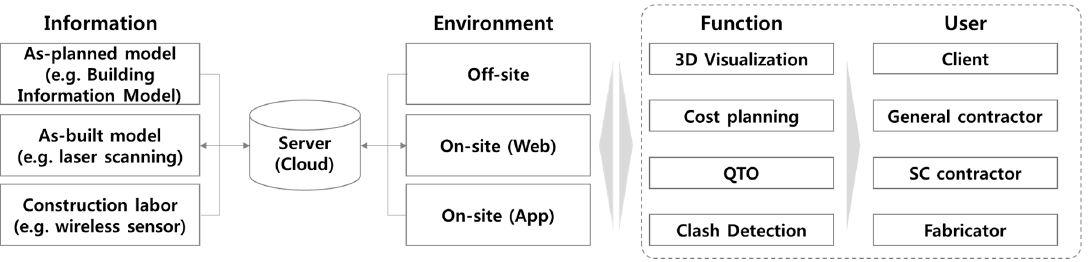
Figure 1. Conceptual diagram of BIM-based construction .